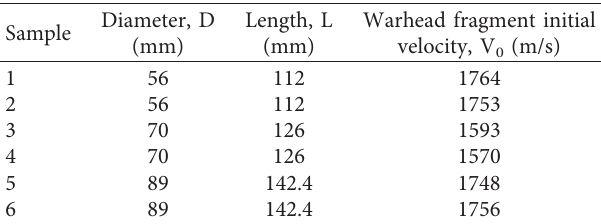
Figure 4: Target penetration process of prefabricated fragments driven by explosion. Table 2: Measured values of the initial velocity of the warhead